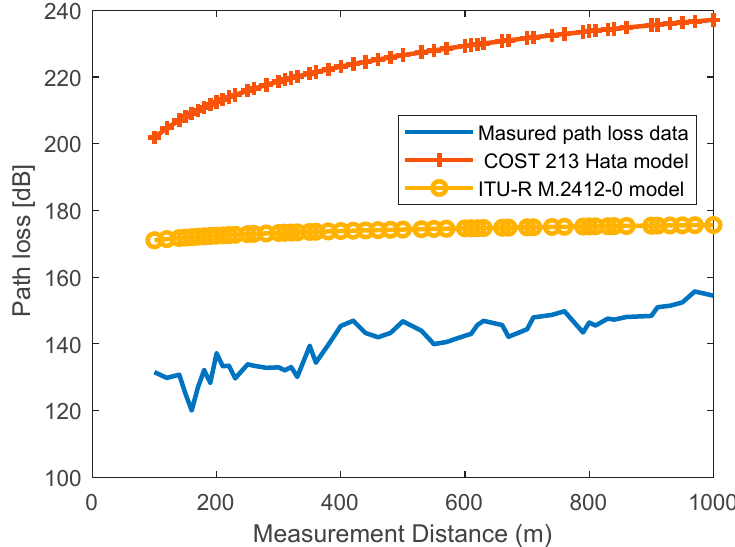
Figure 3. Measured Path loss values versus distance and Prediction comparison with standard COST 231 and ITU-R M.2412-0 model in site 1 Location 1.